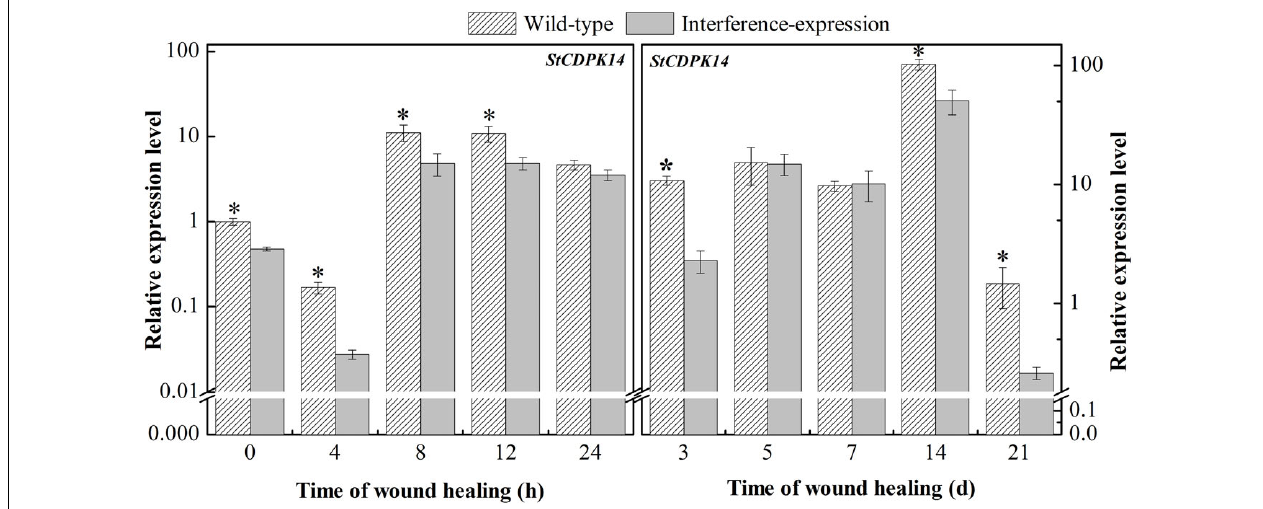
FIGURE 6 | The relative expression of StCDPK14 in transgenic tubers. The potato elongation factor 1-alpha 1 ( efla) gene was used as an internal control to normalize the data. The mean ( ± SD) represents the value of three replicates. Asterisks indicate statistical significance ( P <